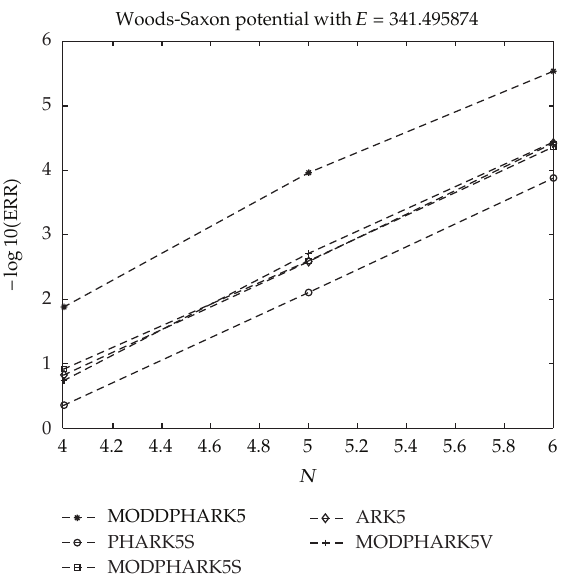
Figure 3: E ffi ciency curves for E (cid:7) 341 .